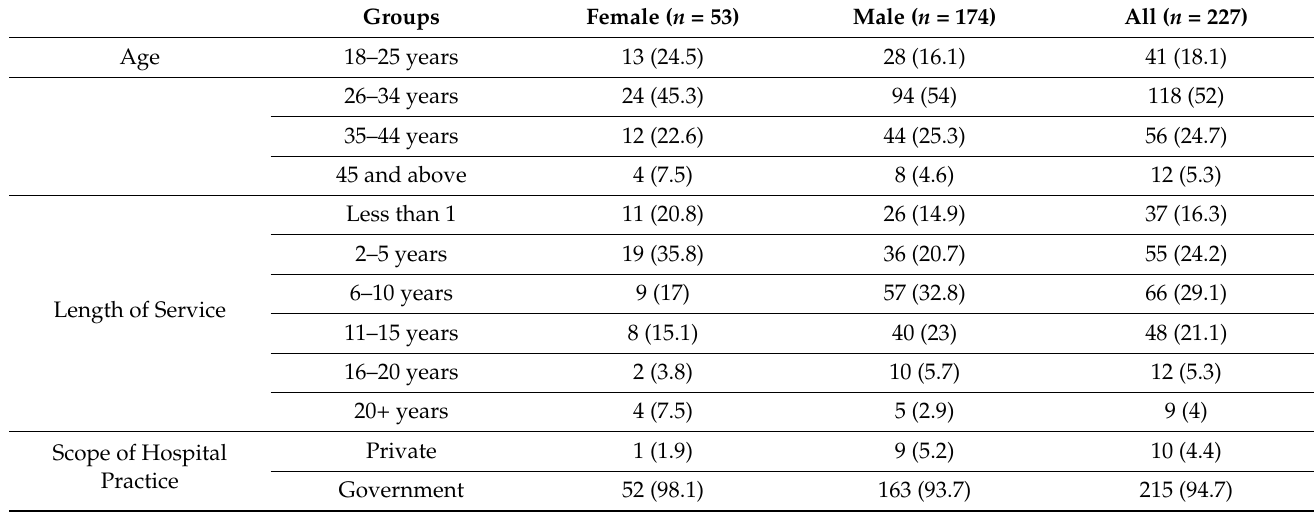
Table 1. Demographic characteristics of the